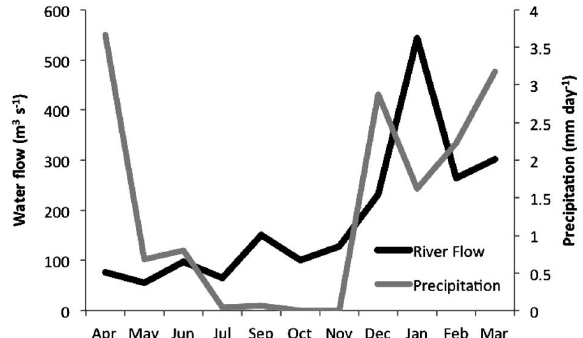
Fig. 5. – Mean weekly and monthly values of river flow and pre- cipitation in the Guadiana River region between April 2010 and March 2011. Source: INAG (2012) (http://snirh.inag.pt/snirh). Data records: Alqueva.